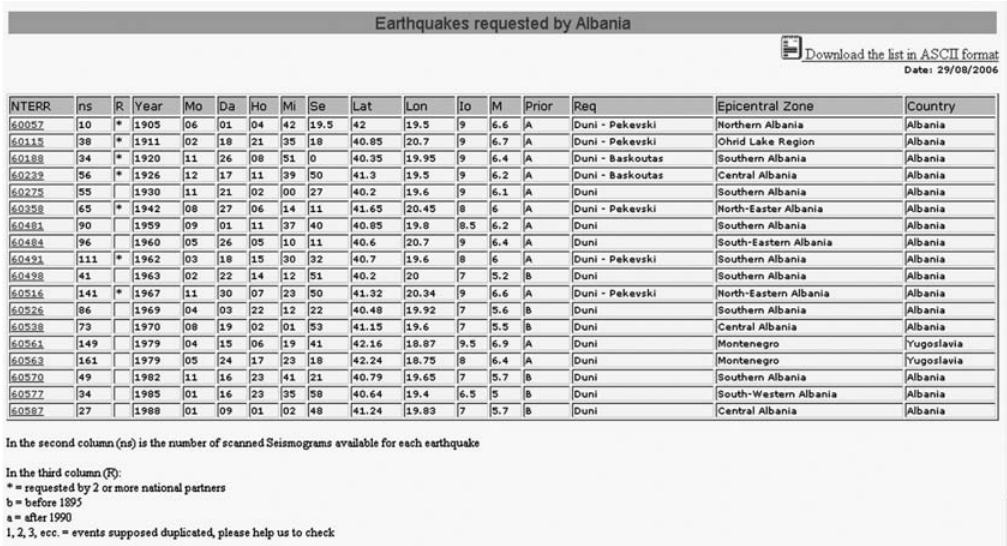
Fig. 13. For each project partner a page is active with the list of chosen earthquakes, which allows us to access, by means of the link of the NTERR column the updated situation of the seismograms and the data available for each